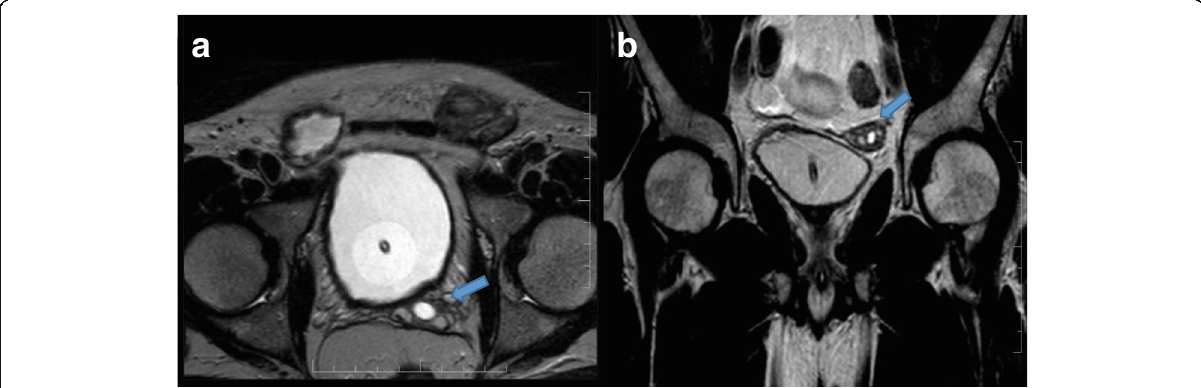
Fig. 3 MRI T2W axial ( a ) and coronal ( b ) images of pelvis shows single left seminal vesicle (arrow) with aplastic right seminal